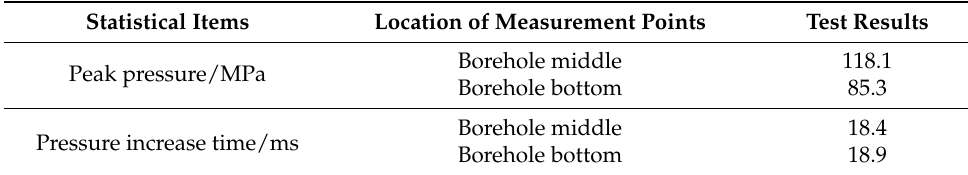
Table 6. Statistical results of borehole wall pressure test.